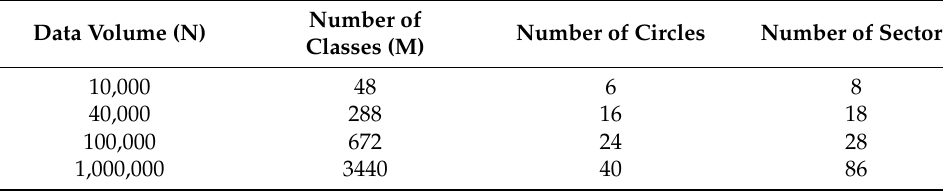
Table 1. Data dependency between the number of classes (M) and data volume (N).